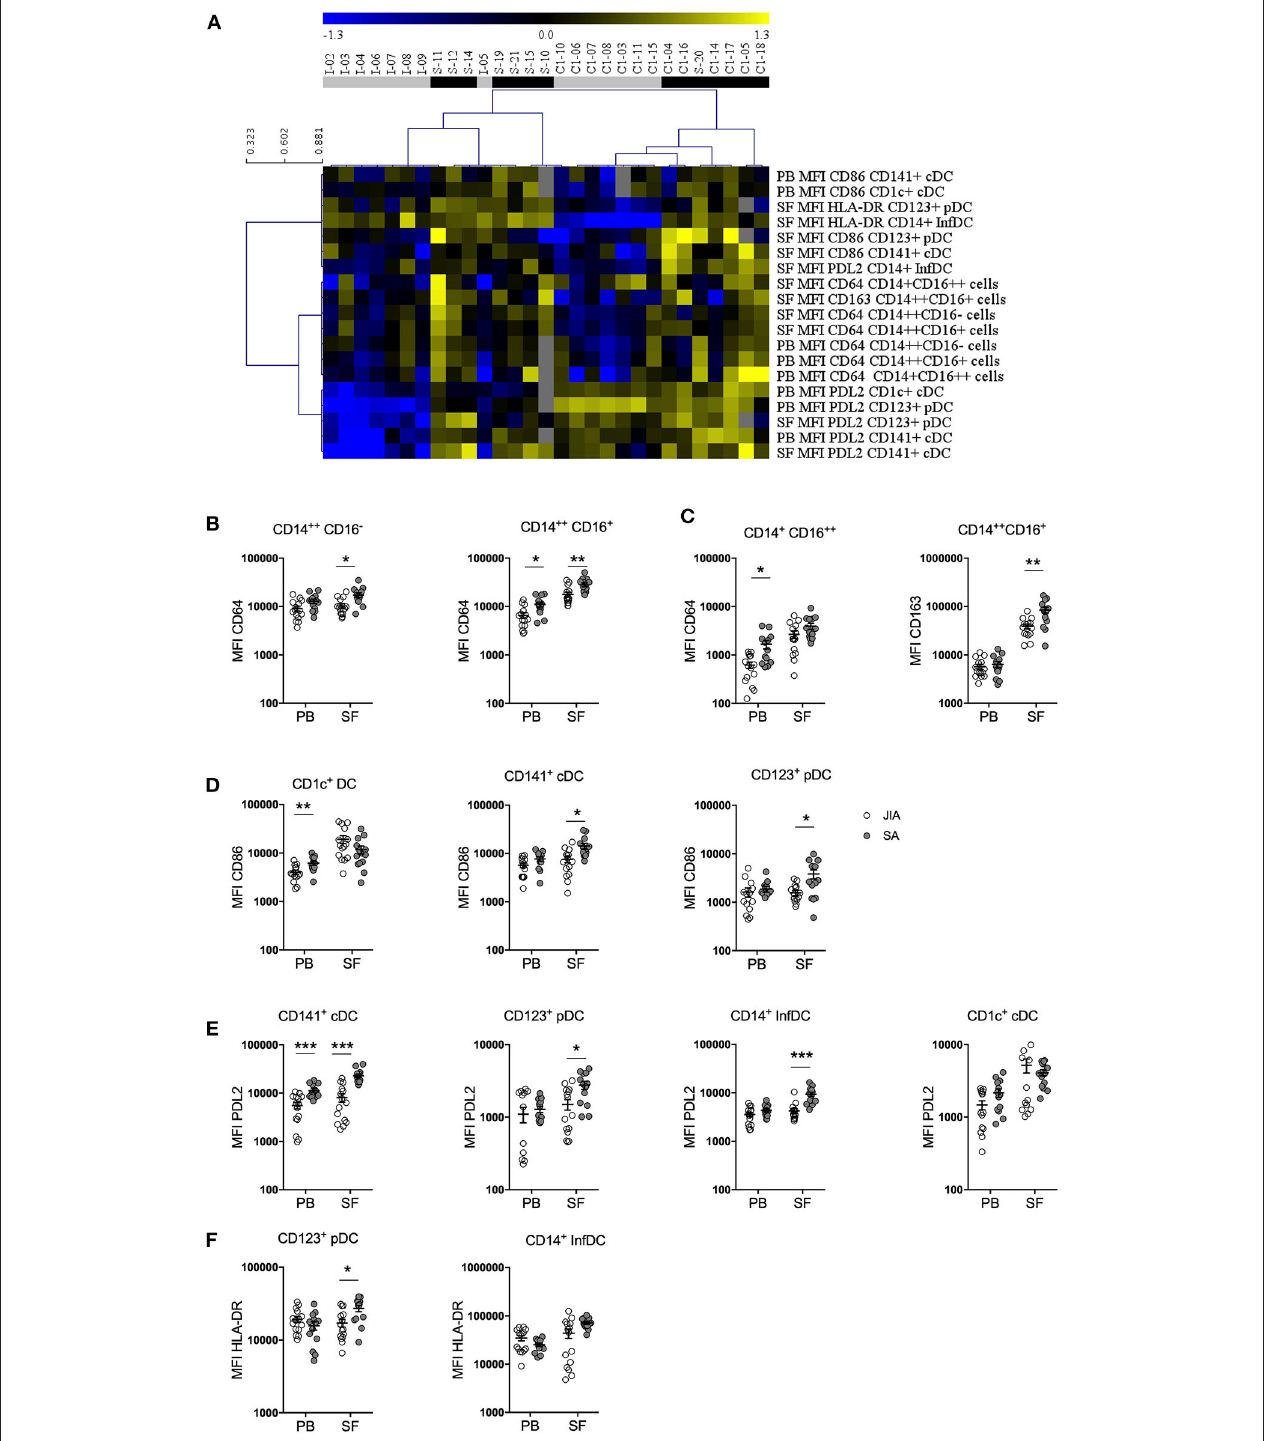
FIGURE 4 | Stratification of patients with JIA and SA based on DC and monocyte activation markers. (A) Heatmap showing the mean fluorescence intensities (MFI, rows) of activation markers that were differentially expressed in JIA (gray, n = 15) and SA (black, n = 14) patients (column). The dendrogram shows the results of the non-supervised hierarchical clustering analysis using an FDR cut-off of 5%. Yellow indicates relative higher expression, blue relative lower expression of the markers and gray undetermined data. Direct comparison of the expression of (B) CD64 and (C) CD163 in monocyte subsets and (D) CD86, (E) PDL2, and (F) HLA-DR in DC subsets in blood (PB) and synovial fluid (SF) samples of patients with JIA (white, n = 15) and SA (gray, n = 14); Data are represented for all patients and horizontal bars are mean ± SEM. * p < 0.05; ** p < 0.01; *** p < 0.001; **** p < 0.001 (two-sided t or Mann–Whitney test, according to data distribution after FDR adjustment).